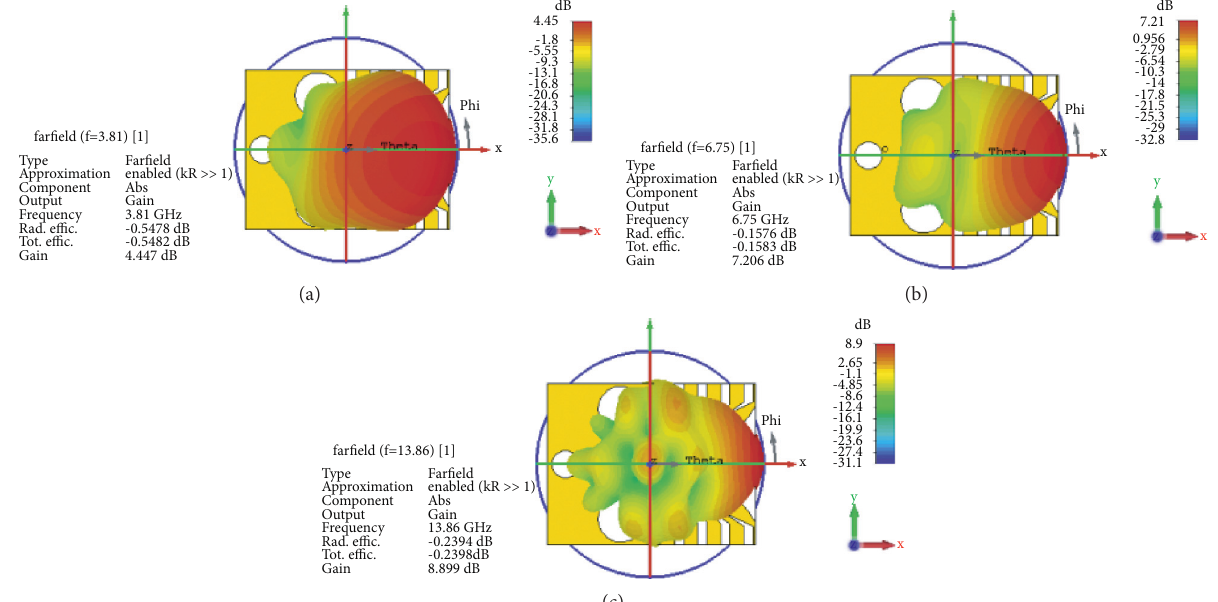
Figure 6: 3D radiation pattern at (a) 3.81GHz, (b) 6.75GHz, and (c) 13.86GHz.